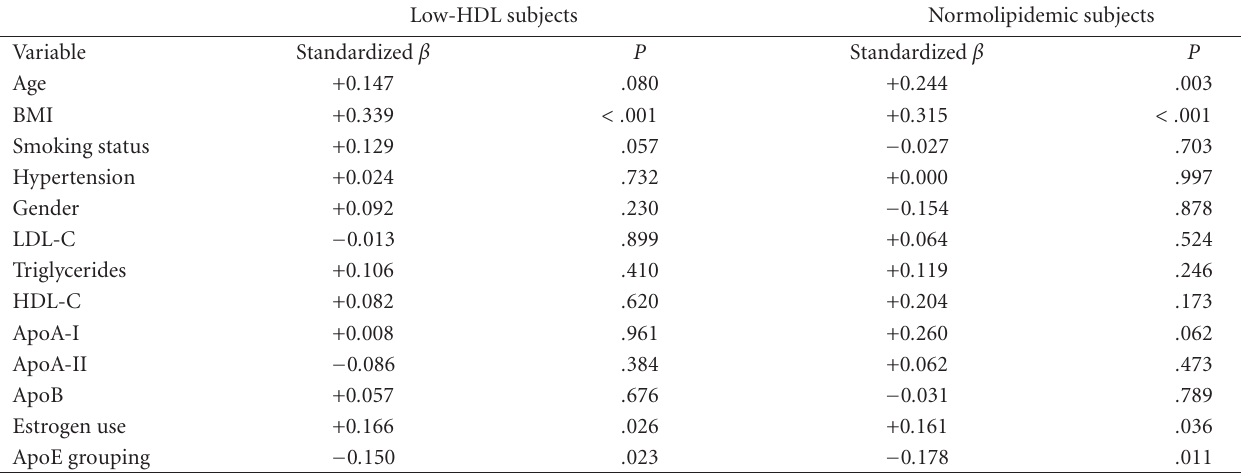
Table 3: Multiple regression analysis of predictors of CRP values in low-HDL and normolipidemic